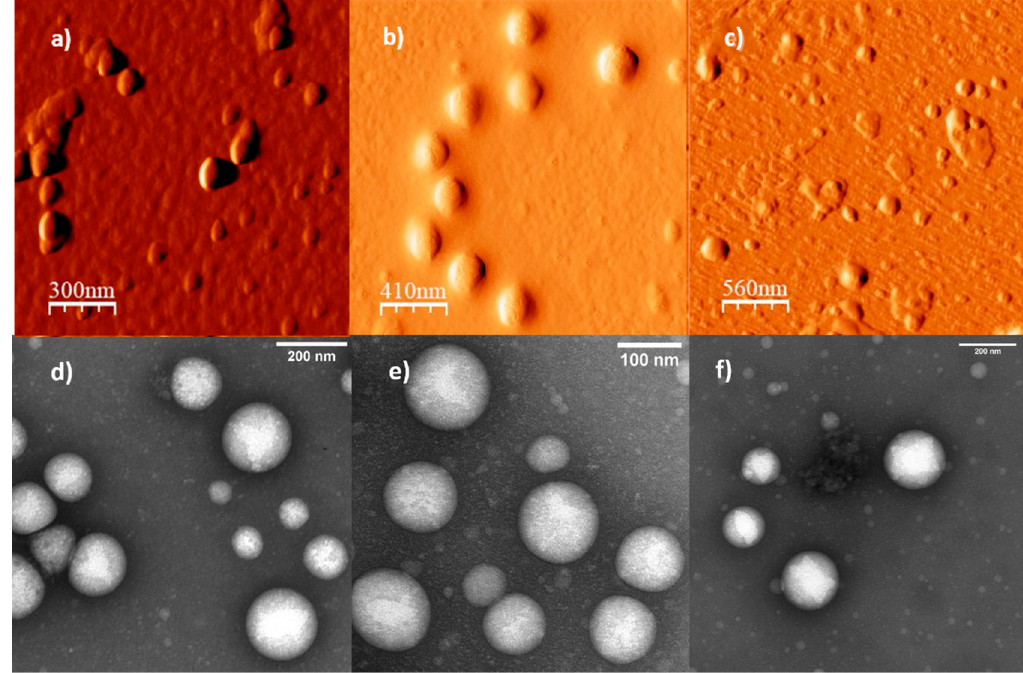
Figure 4. AFM and TEM micrographs for some aggregates obtained by solvent exchange for the copolymers: ( a ) AFM image of P 51 D 47 , ( b ) AFM images of P 122 D 54 , ( c ) AFM images of P 122 D 96 , ( d ) TEM image of P 51 D 47 , ( e ) TEM image of P 122 D 54 , and ( f ) TEM image of P 122 D 96 . AFM Images obtained on mica substrate by tapping mode and TEM images with uranyl acetate stained samples on copper grids.